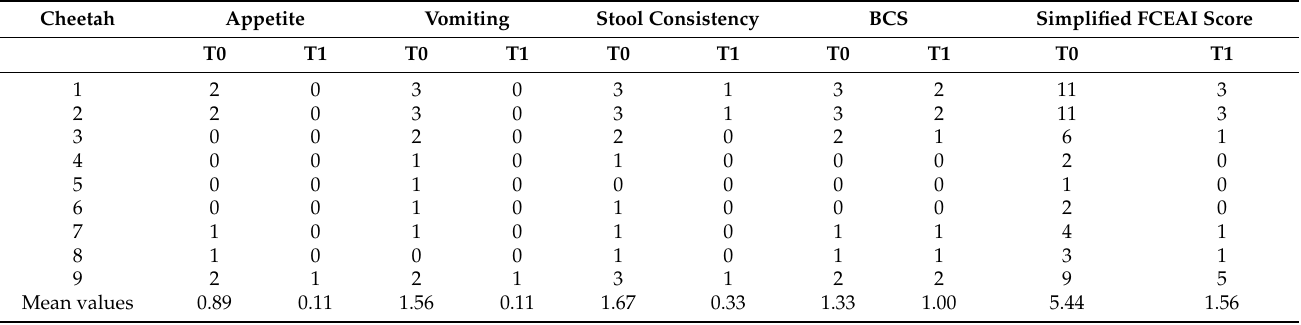
Table 3. Simplified FCEAI score in Group B at T0 and